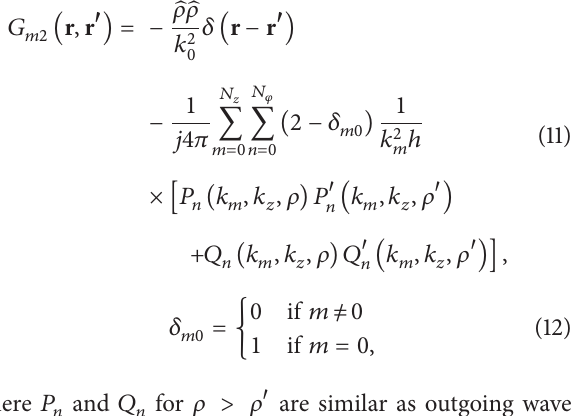
Figure3:The 𝑆 -parametersversusfrequencyfromanalysisandCST.